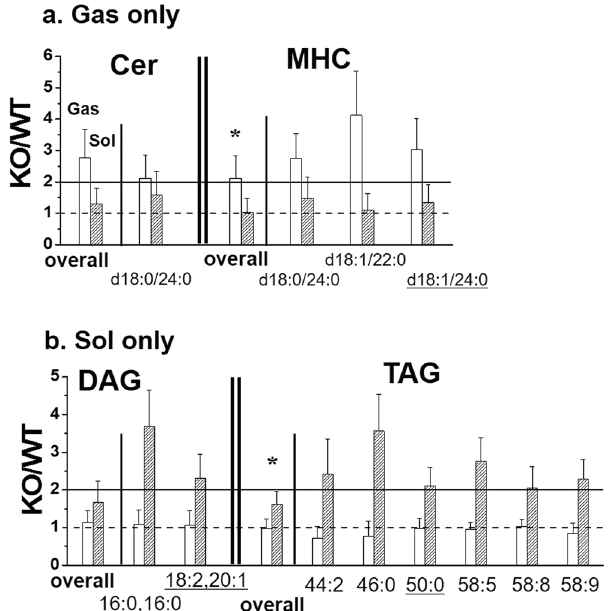
Figure 6. Changes (KO/WT) in a) the Cer and MHC species with a significant change ( > 2-fold and p < 0.05) in the Gas only and b) the DAG and TAG species with a significant change in the Sol only. Underlined species are the highly abundant